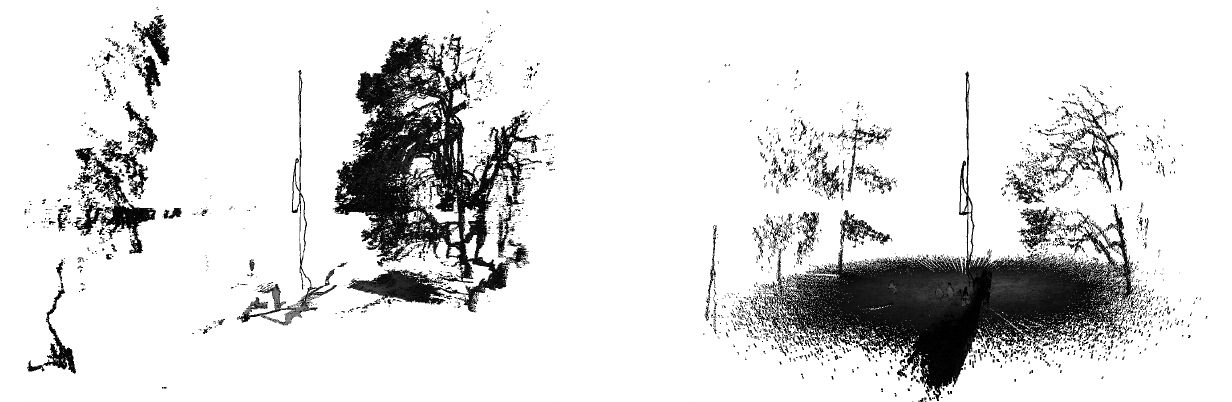
Figure 4. Point clouds acquired with the horizontally oriented line scanner (left) and with the vertically oriented line scanner (right). Note that the point density in the tree crowns is significantly higher on the left, whereas the scene coverage is larger on the right.